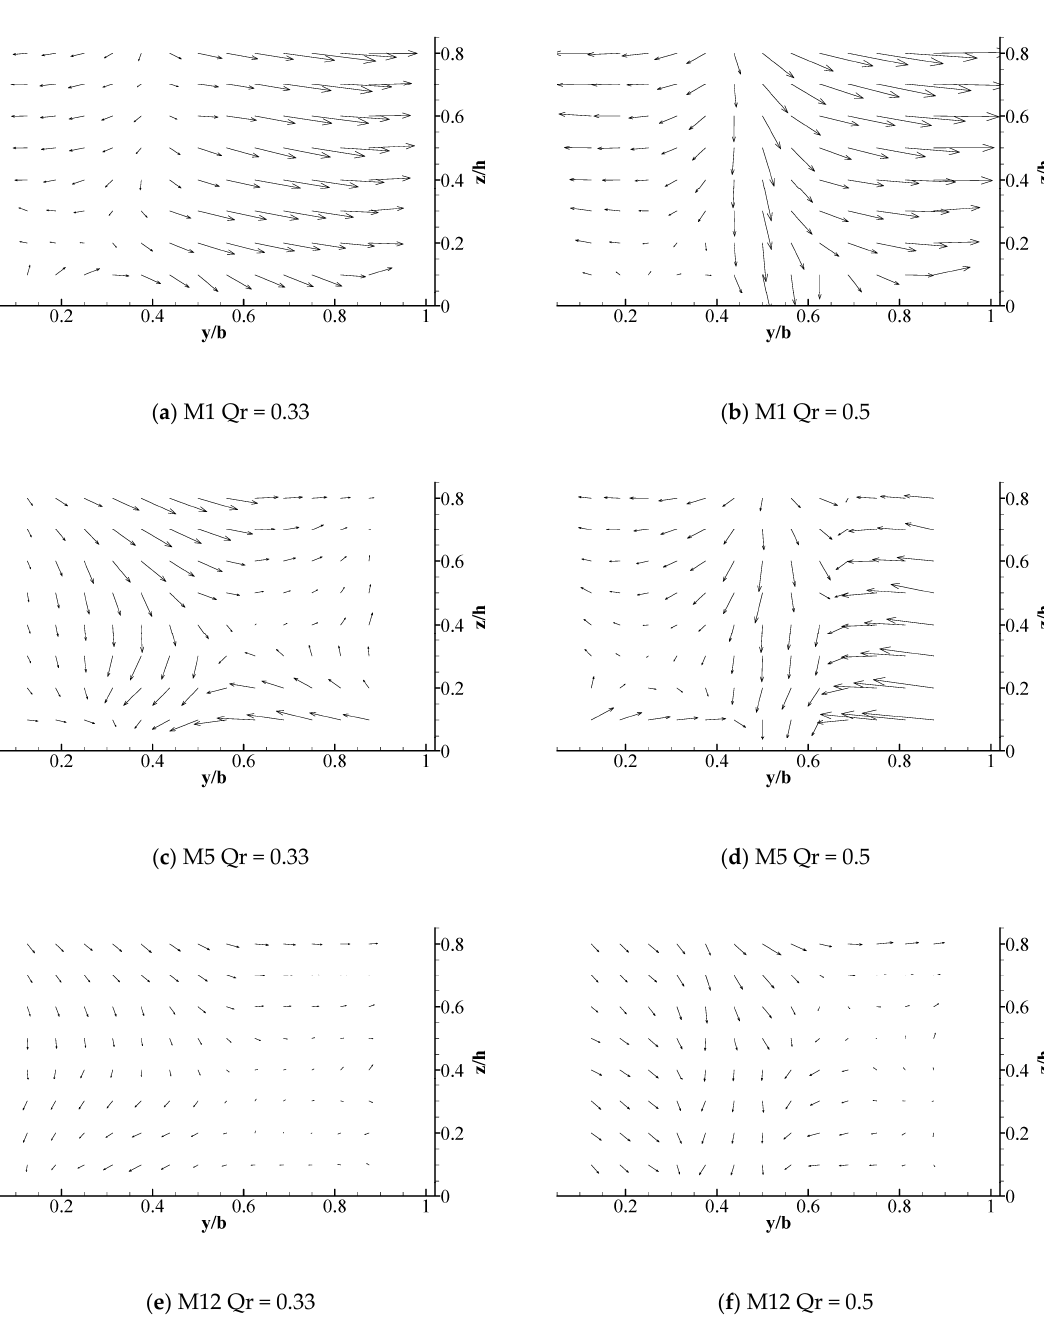
Figure 6. Longitudinal flow velocity distribution and secondary flow structure in the mainstream measurement section.